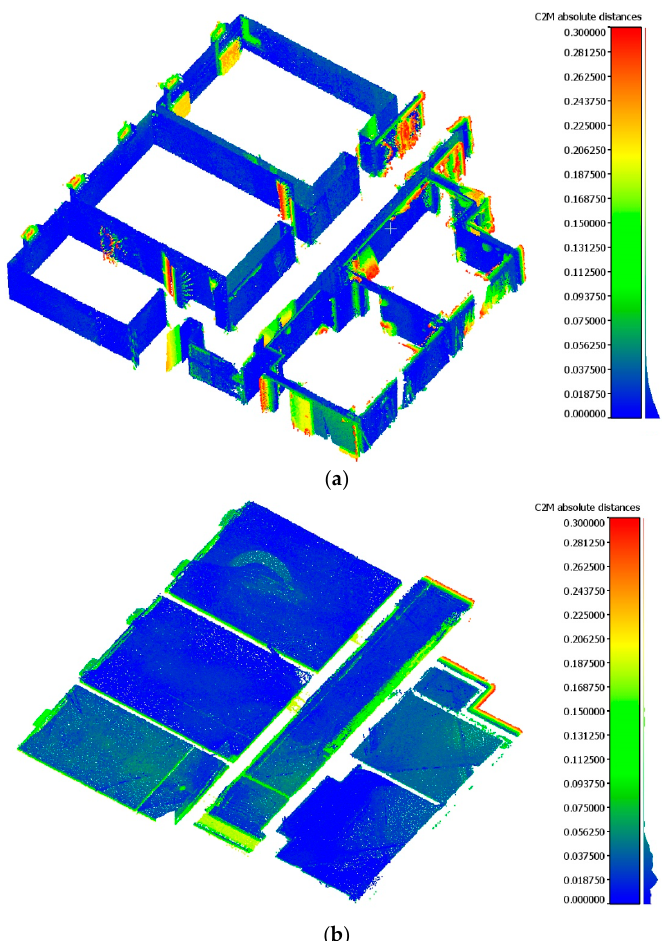
Figure 13. Point clouds colored with points-to-model unsigned distances for walls ( a ) and ceiling ( b ).